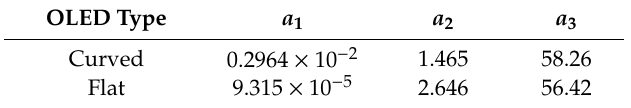
Figure 8. Comparison of a flat and curved OLEDs employed in the office in term of optical path loss (OPL). Table 3. Numerical modeling parameters for OPL in the case of using flat and curved OLEDs in office.